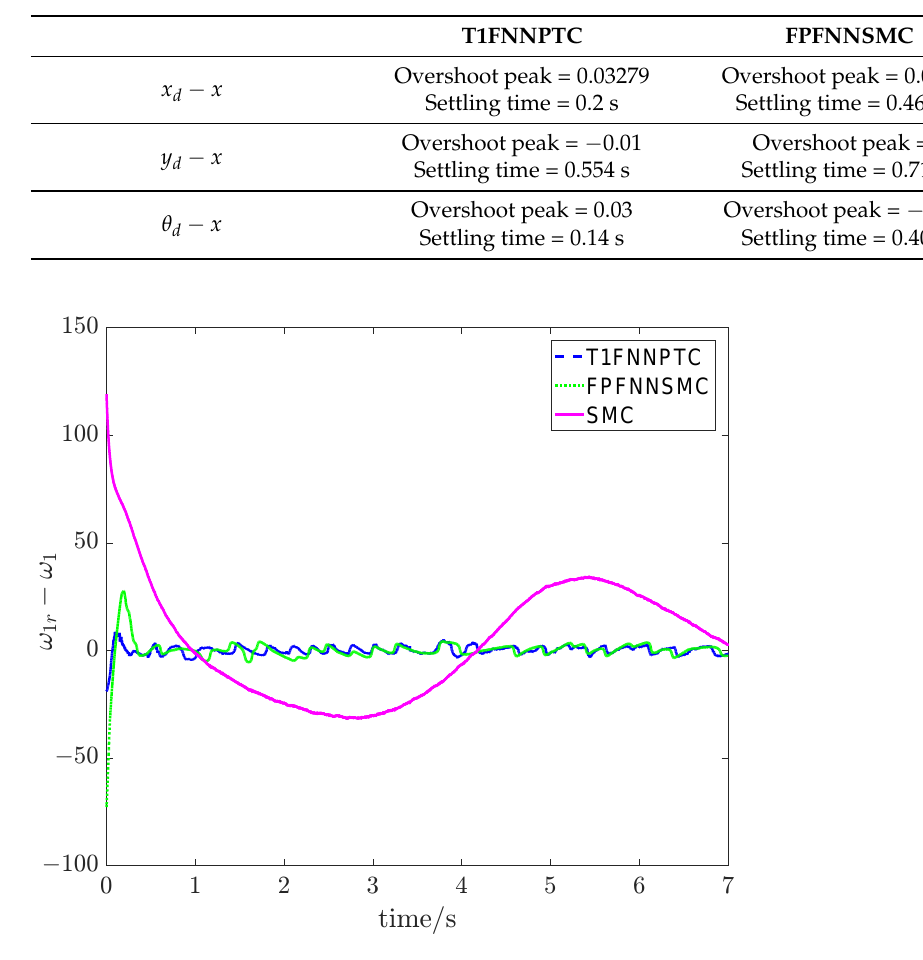
Figure 10. Tracking error of ω 1